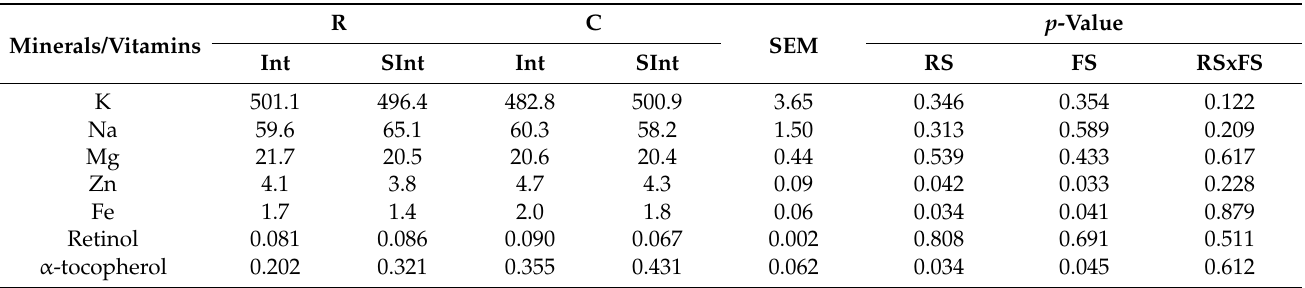
Table 5. The influence of rearing system and intensity of fattening on the content (mg/100 g of fresh meat) of minerals and